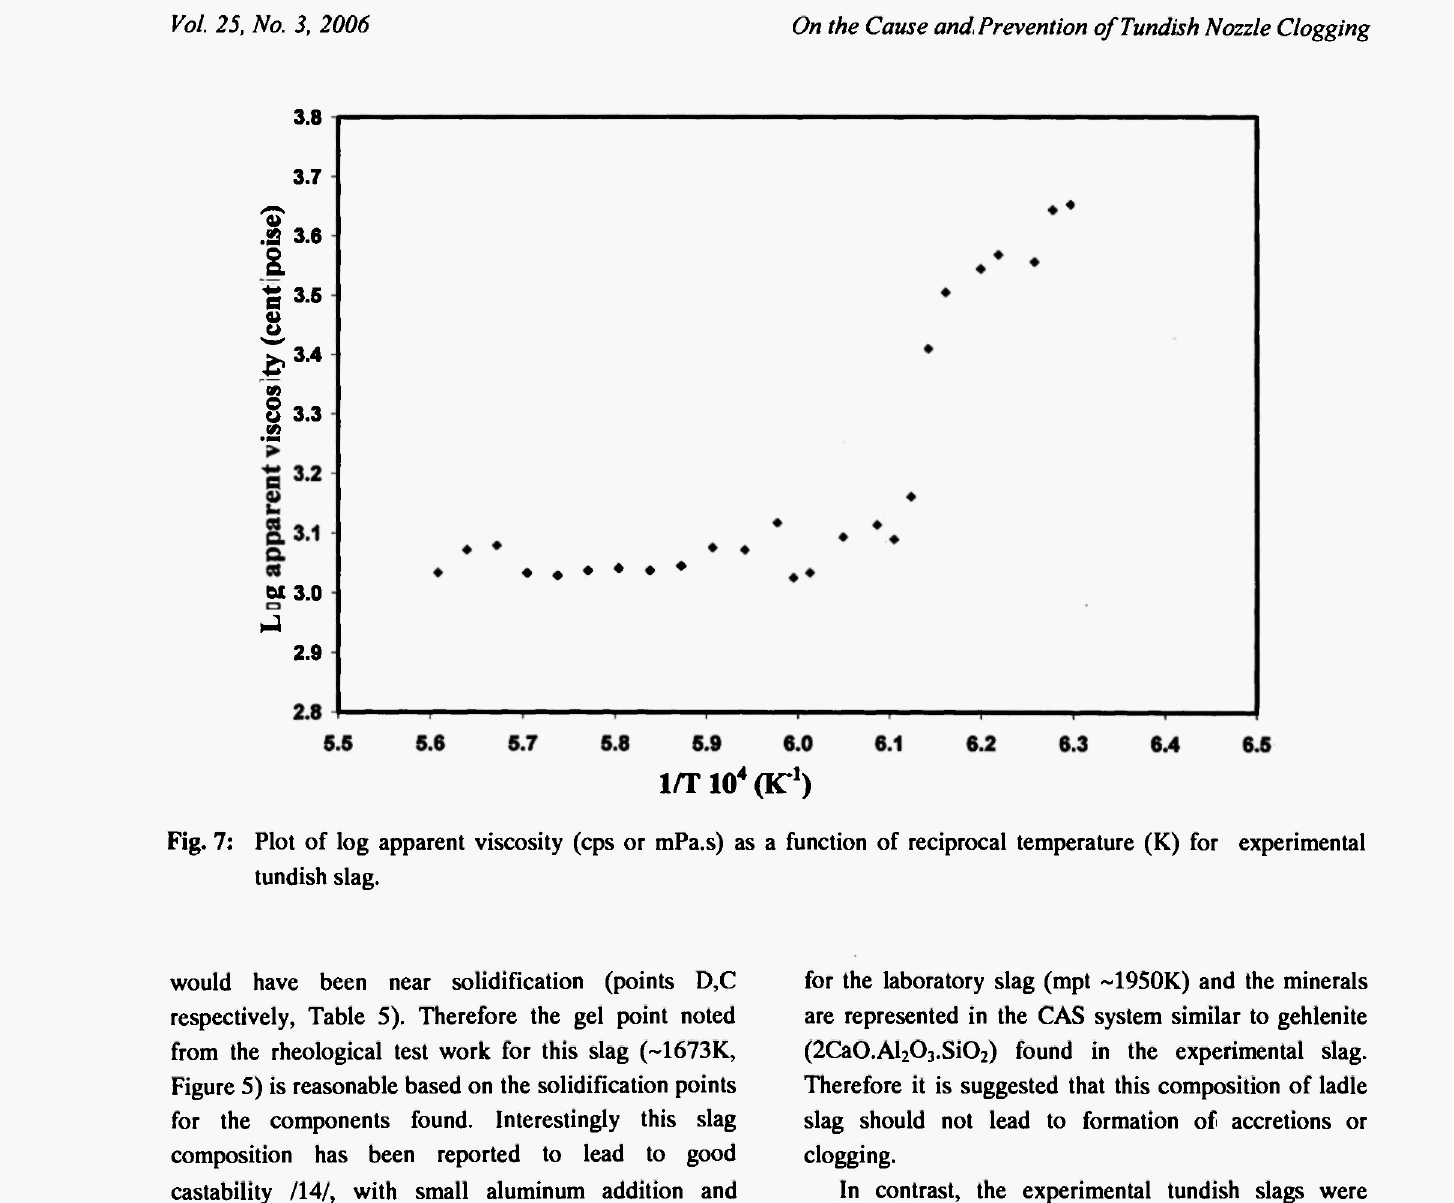
Fig. 7: Plot of log apparent viscosity (cps or mPa.s) as a function of reciprocal temperature (K) for experimental tundish